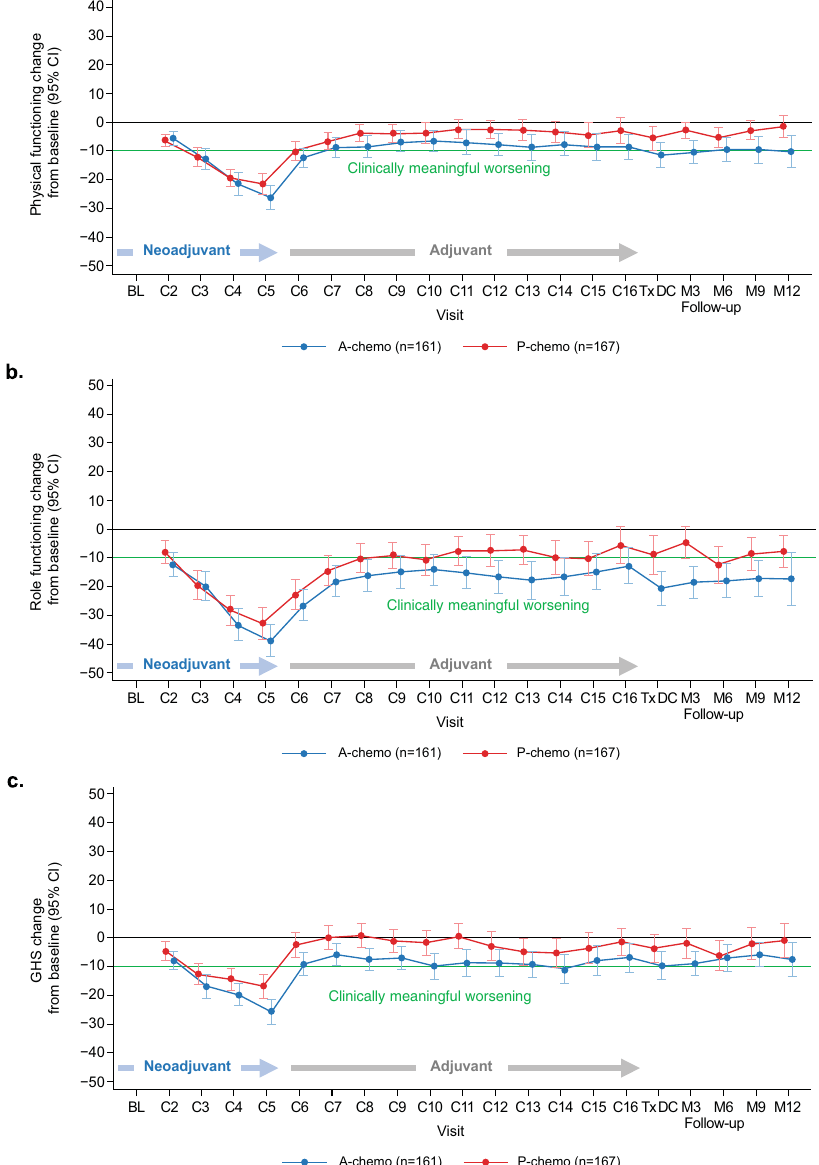
Fig. 2 Mean change from baseline values at each time point in physical function, role function, and HRQoL. Error bars indicate 95% con fi dence intervals. Mean change from baseline values at each time point in a physical function, b role function, and c HRQoL was measured using the EORTC QLQ-C30. A atezolizumab, C cycle, GHS global health status, M month, P placebo, Tx DC treatment